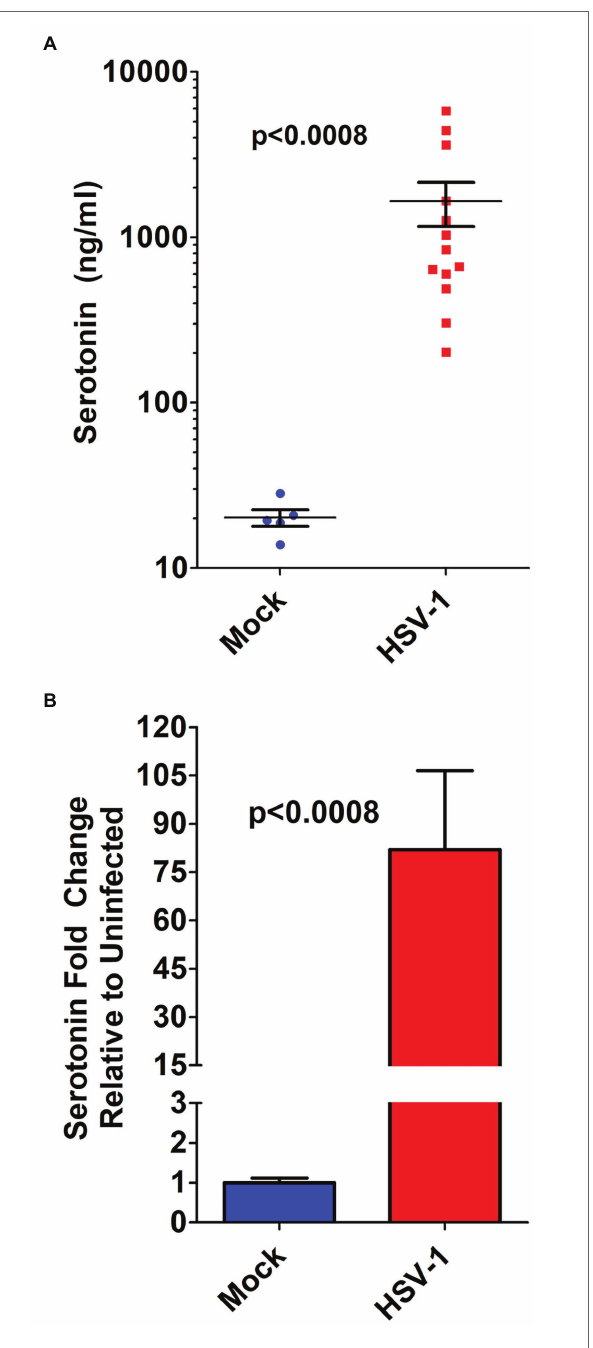
FIGURE 7 | Serotonin concentration in the aqueous humor of HSV-infected eyes is markedly increased in a rabbit model of acute herpes keratitis. (A) ELISA determination of serotonin concentration from the aqueous humor of individual rabbit eyes that was mock- or HSV-1-infected. (B) Fold change in serotonin concentration in the aqueous humor of rabbits mock infected or HSV-1 infected. Data graphed as mean ±